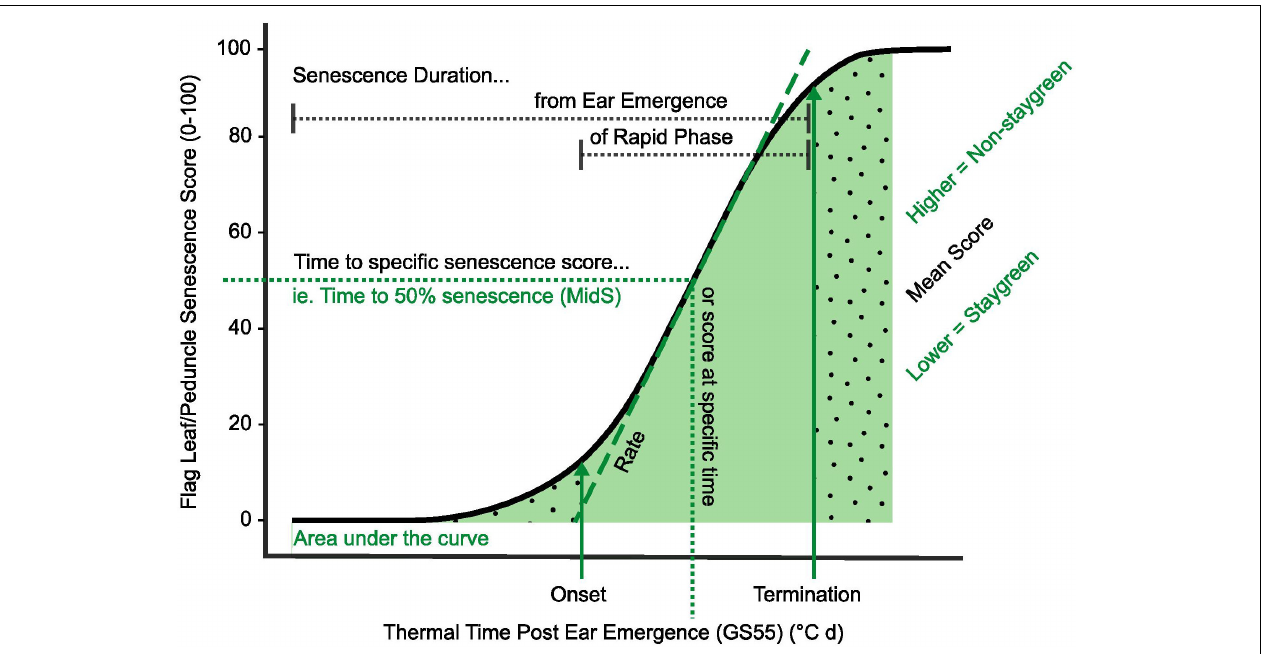
FIGURE 2 | Key parameters used in quantification and characterization of senescence variation. Metrics relating to onset, rate, and duration of senescence, alongside total greenness (area under the curve) and dynamic measures (including MidS), can be calculated from time course data ( Table 2 ). Onset of senescence marks the transition between the initial lag phase (dotted fill, right) and rapid phase of senescence (solid fill, center). As senescence nears completion, the senescence rate decreases, resulting in a final lag phase (dotted fill, left). To compare senescence progression of different lines, time to different senescence scores (MidS), an overall mean, or total greenness can be calculated.